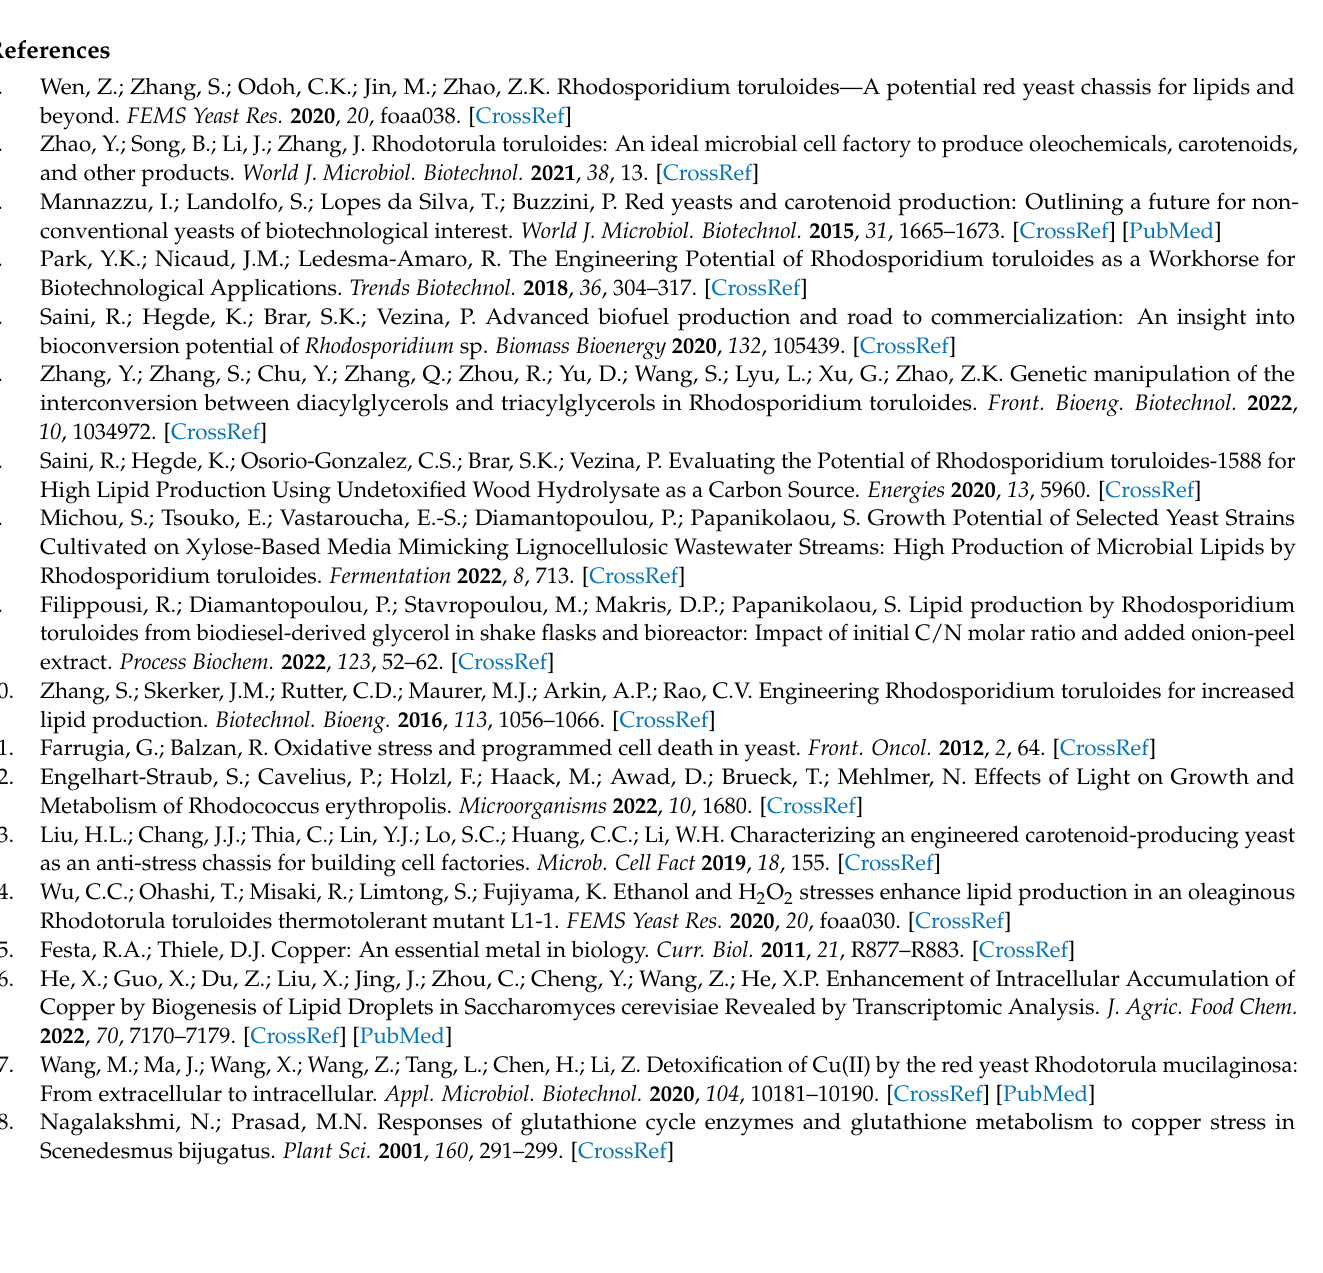
Table S2: Proteomics-Cu-IFO0880.xlsx; Table S3: OD; Table S4: DCW; Table S5: Carotenoid accumu- lation; Table S6: Lipid accumulation; Table S7: Fatty acid profile; Table S8: Differentially expressed proteins of zinc involved processes discussed here; Figure S1: pH control in growth of haplotypes; Figure S2: Vulcano plots of proteomic